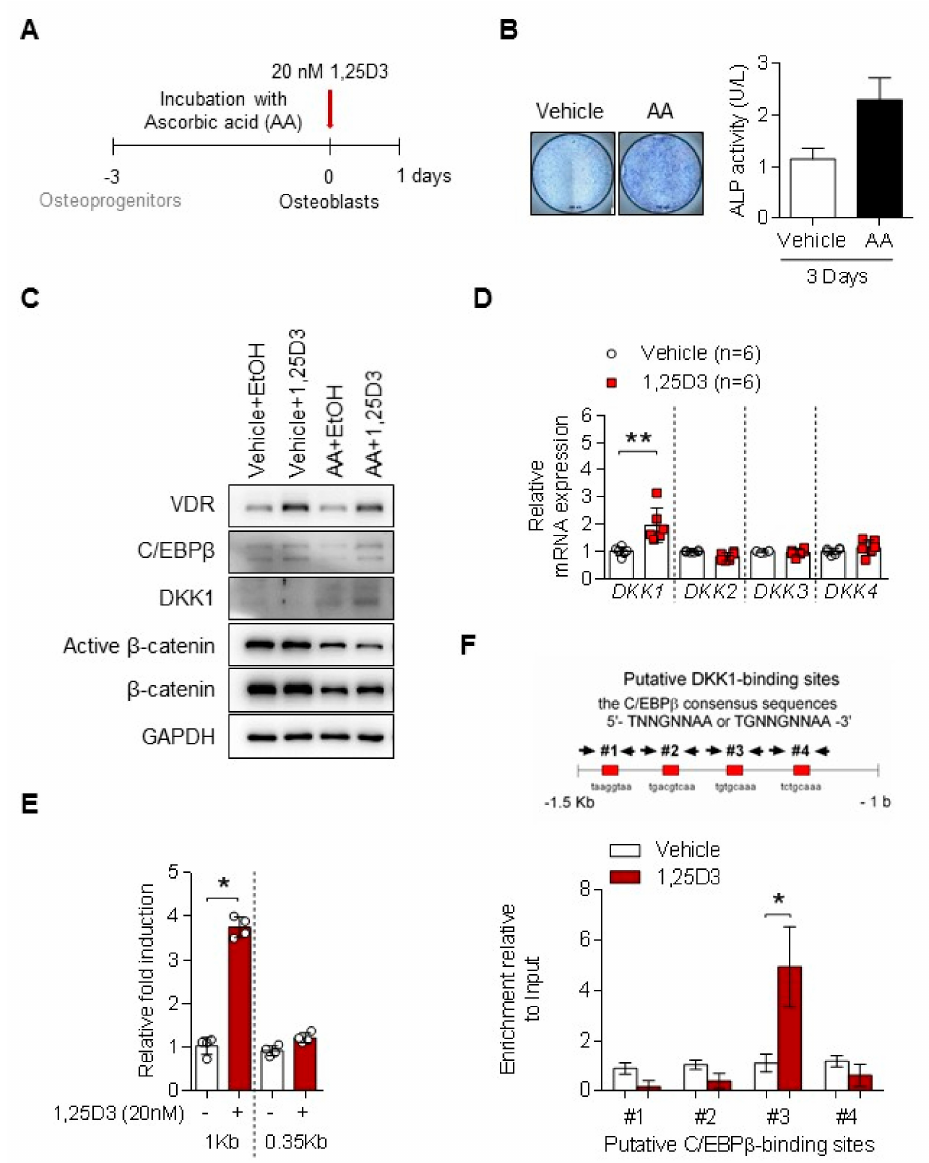
Figure 2. 1,25D3 induces expression of DKK1 in osteoblasts through C / EBP β . ( A ) Experimental scheme for induction of osteoblasts. ( B ) Osteoprogenitors were stimulated with 50 nM AA for 3 days, incubated with 20 nM 1,25D3 for a day, and analyzed by ALP staining and intracellular ALP activity. ( C ) Osteoprogenitors (vehicle) or osteoblasts (AA) were treated with 20 nM 1,25D3 for 24 h and analyzed by immunoblotting ( n = 6). ( D ) DKK genes in 1,25D3-induced osteoblasts were analyzed by qPCR ( n = 6). ( E ) Osteoblasts were transfected with 1 kb DKK1 or 0.35 kb DKK1 for 48 h, treated with 20 nM 1,25D3 for 24 h, and then analyzed with luciferase assay ( n = 4). ( F ) Osteoblasts were treated with 20 nM 1,25D3 for 24 h then subjected to ChIP assay ( n = 4). Representative data are shown. * p < 0.05, ** p < 0.01; (mean ±